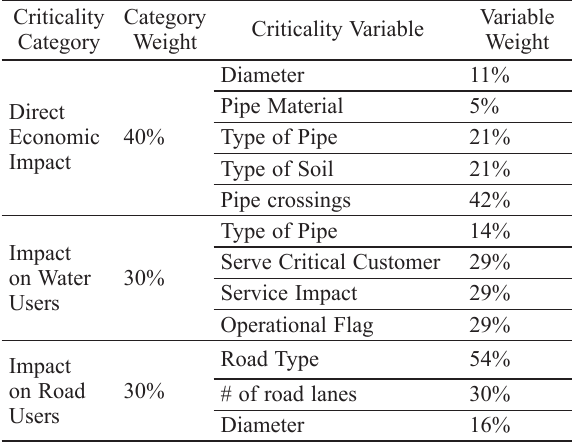
Table 2. Relative weights for criticality